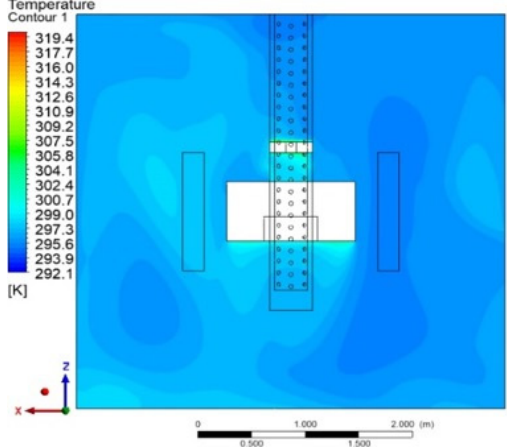
Figure 32. The temperature distribution of the Y = 2 m section.